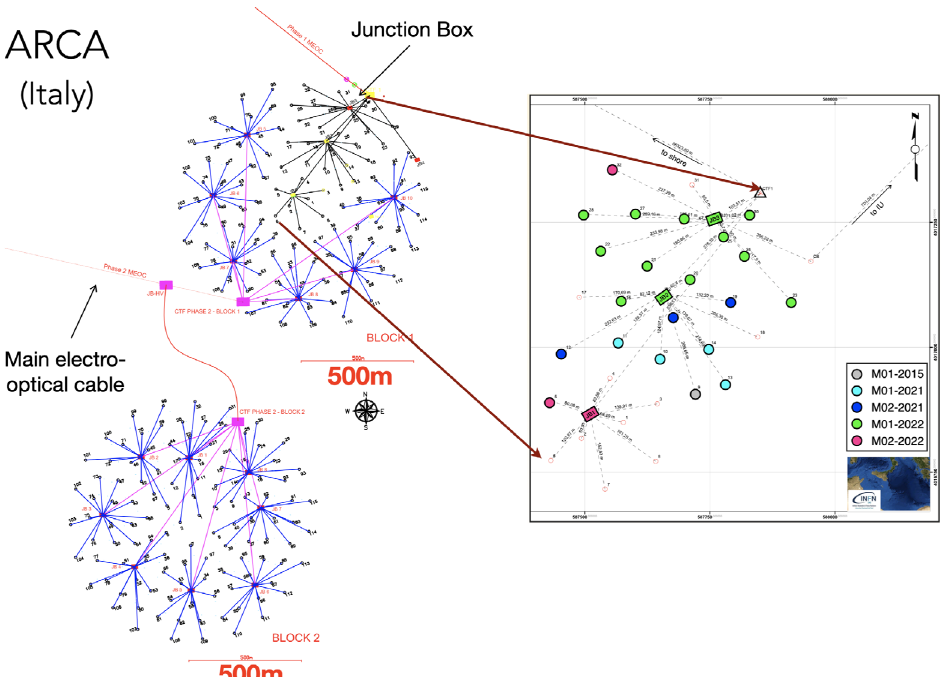
Figure 1. Left: Layout of the completed ARCA detector. Two building blocks of 115 detection units are connected to shore via a network of submarine electro-optical cables and Junction Boxes. Two main electro-optical cables are installed on the seafloor and connected to the onshore laboratory, for power feeding and data acquisition. Right: A zoom of the so-called ARCA Phase-1. The installed detection units (Junction Boxes) are indicated with a coloured circle (rectangle). The colour scheme follows the sequence of marine campaigns indicated by a progressive number and the